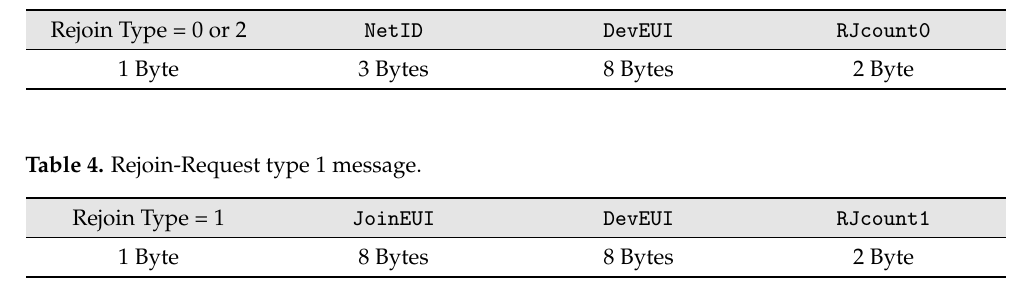
Table 3. Rejoin-Request message of type 0 or type 2.